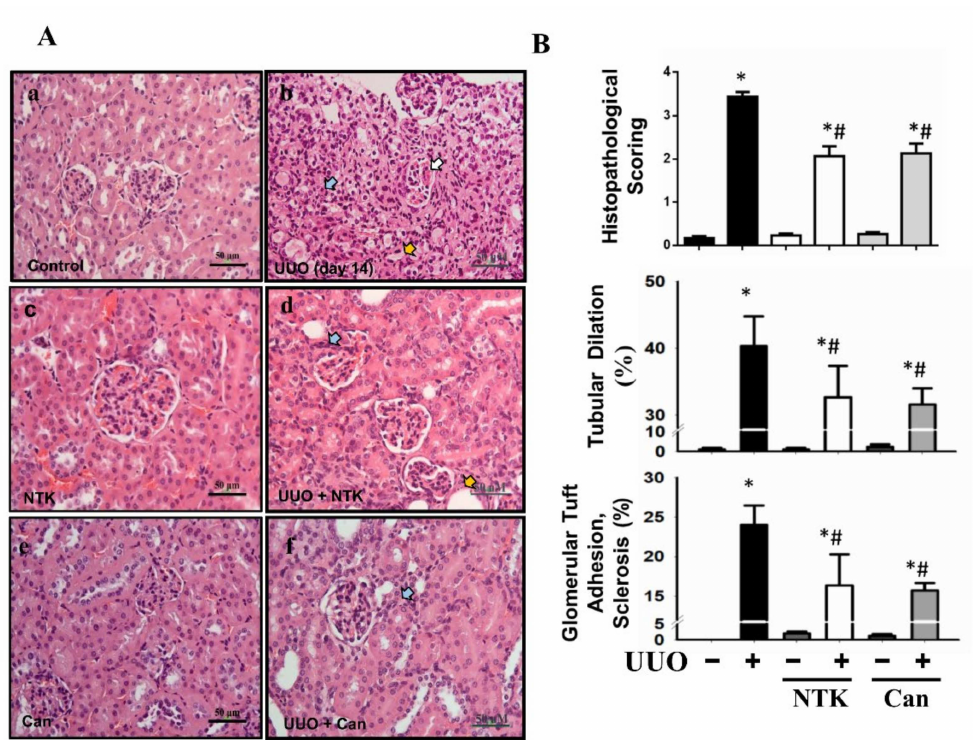
Figure 1. Effects of Nootkatone treatment on the renal pathological changes in a UUO mouse model. Vehicle, Nootkatone (NKT), or candesartan (Can; positive control) was orally given to the sham or UUO mice for 14 days. ( A ) The pathological changes were determined by hematoxylin and eosin (H&E) staining. The kidney injury features, including kidney tubular dilation (yellow arrow), interstitial infiltration (blue arrow), and glomerular tuft adhesion and sclerosis (white arrow) were indicated. Scale bar: 50 µ m. ( B ) The histopathological scoring is shown Data are presented as mean ± SD ( n = 6). * p < 0.05 vs. the sham control group. # p < 0.05 vs. the UUO